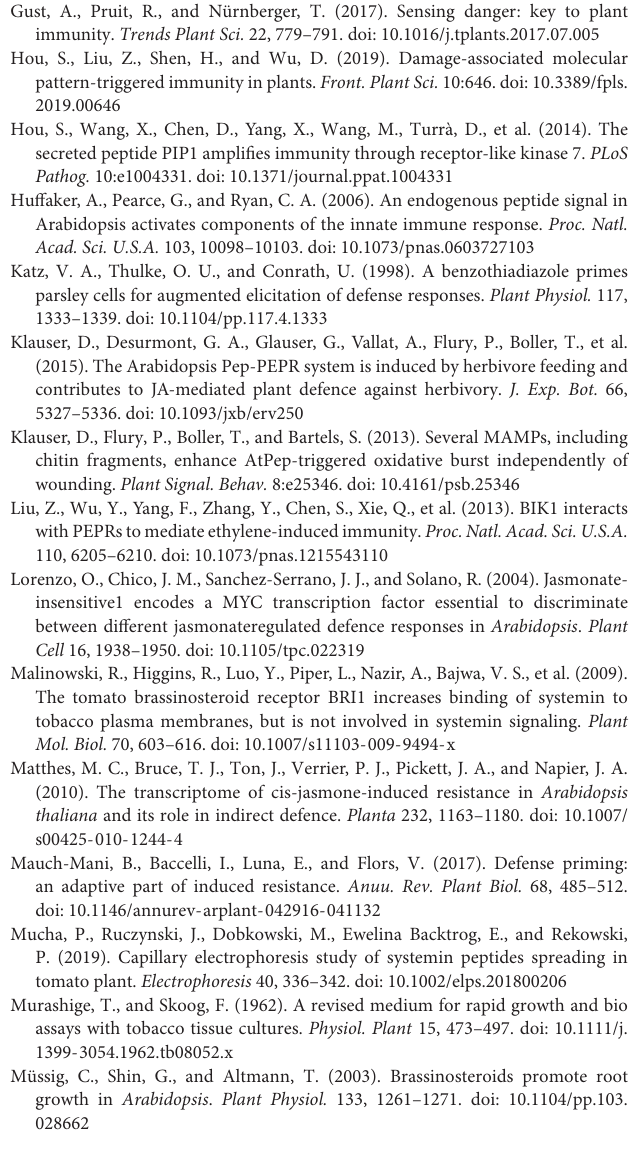
FIGURE S7 | P. cucumerina Infection quantification by measuring fungal biomass. A ratio of PcTUBULIN relative to AtUBIQUITIN21 was calculated after performing a qPCR from gDNA of Arabidopsis infected plant samples 48 h after pathogen inoculation in watered plants and plants treated with 0.1 nM systemin 24 h before inoculation of P. cucumerina. Bars represent mean ± standard error (SD), n = 6. Asterisks mean statistical significant differences; T -test; P < 0.05, n = 6. FIGURE S8 | ROS production areas in response to Systemin and PAMP challenge. H 2 O 2 production was measured during 1 h in leaf disks after elicitation with Systemin at different concentrations and with 100 nM flg22 in leaf disks that were pre-treated for 24 h with different concentrations of Systemin. Luminescence